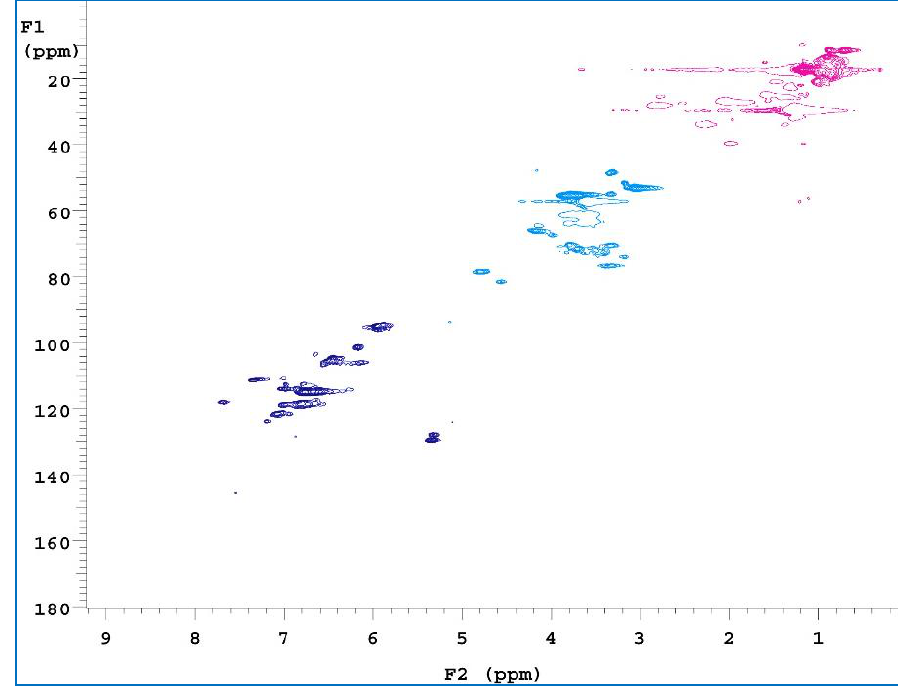
Figure 10. 2D-HSQC NMR spectra of RPB ethanol/methanol extract.